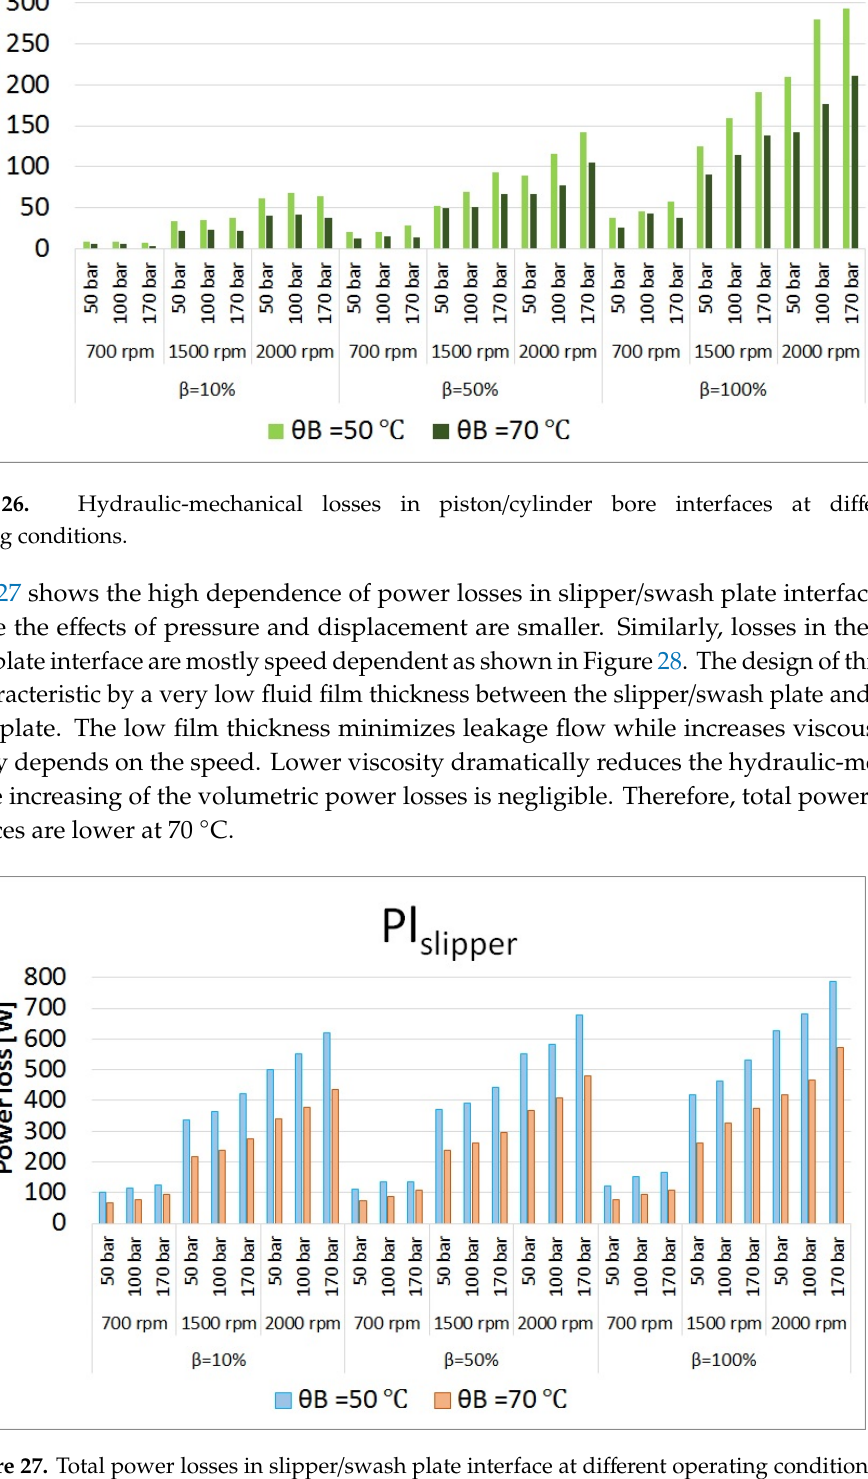
Figure 25. Volumetric power losses in piston/cylinder bore interfaces at different operating conditions.